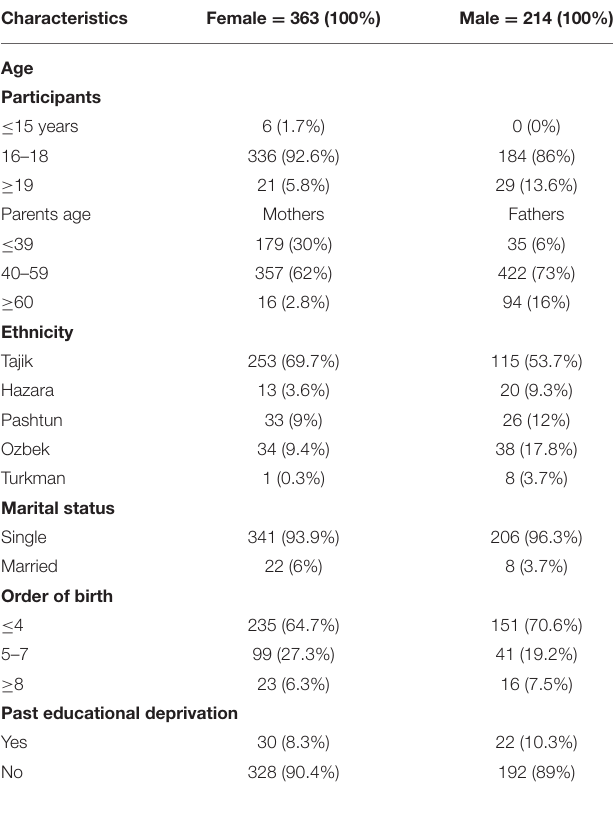
TABLE 1 | Descriptive statistics: Independent variables. Characteristics